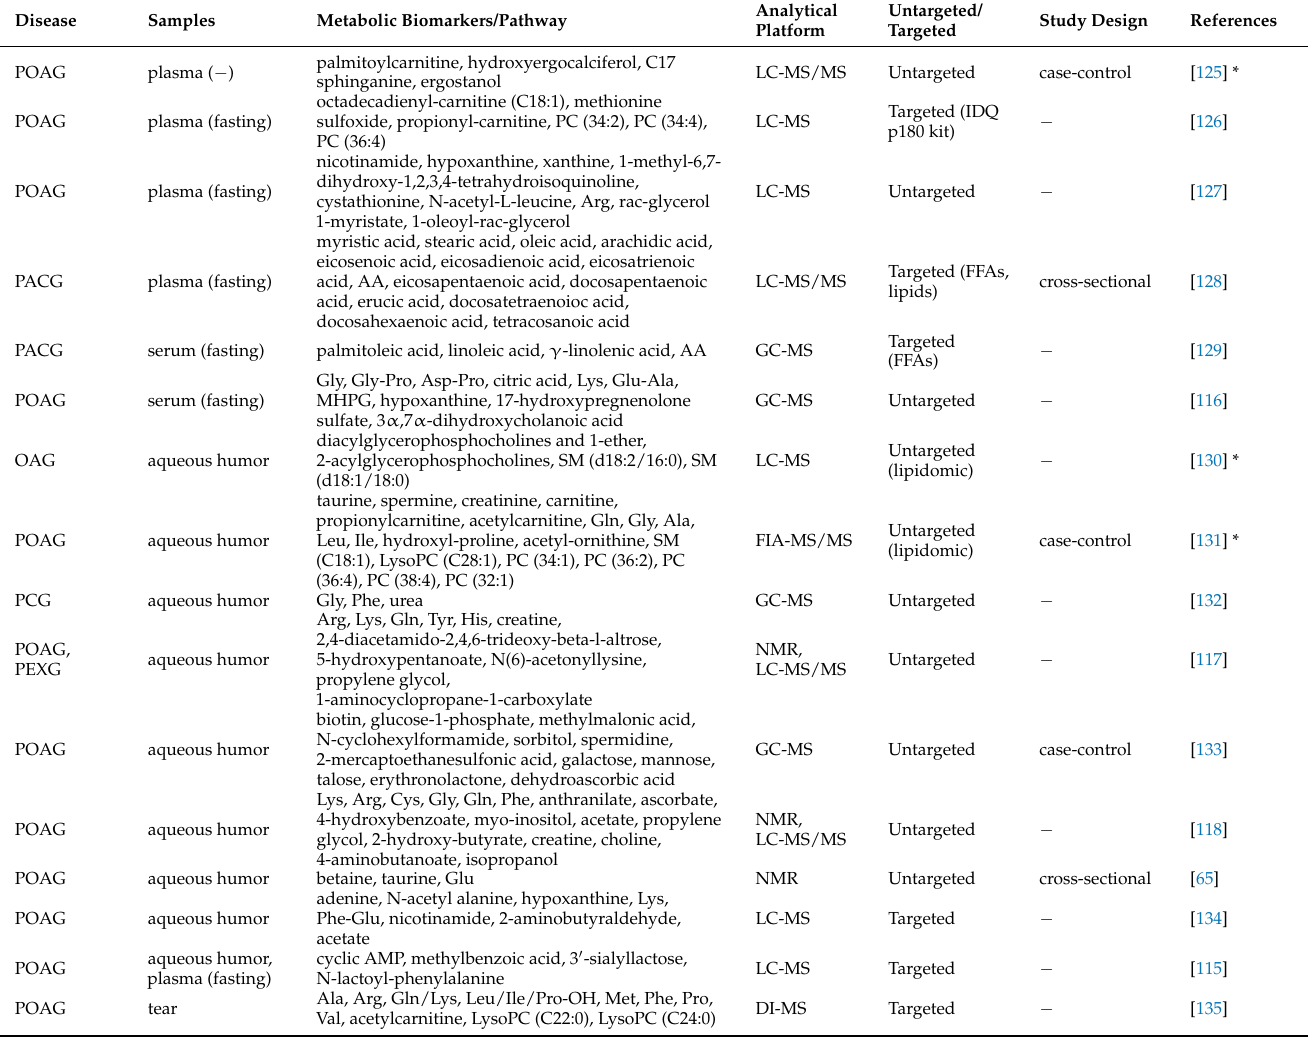
Table 4. Summary of metabolomics-based clinical studies of